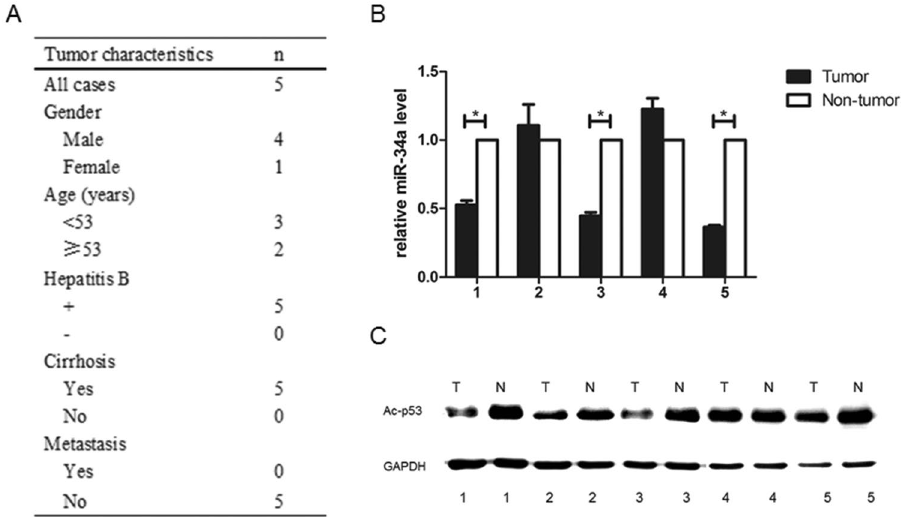
Figure 5. The levels of miR-34a in HCC patients were down-regulated. ( A ) The basic characteristics about the 5 HCC tissues. ( B ) Three out of five HCCs (60%) had decreased miR-34a levels as compared with corresponding non-cancerous hepatic tissues. ( C ) Ac-p53 expression was down-regulated in HCC tissues.